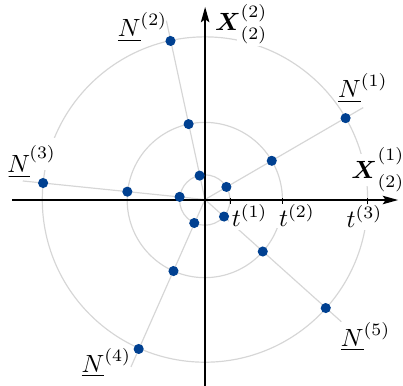
Figure 4. Example of a discretization of the two-dimensional tangent space. The samples are placed along the equidistant (in higher dimensions—uniformly distributed) directions with nonuniformly increasing amplitude.